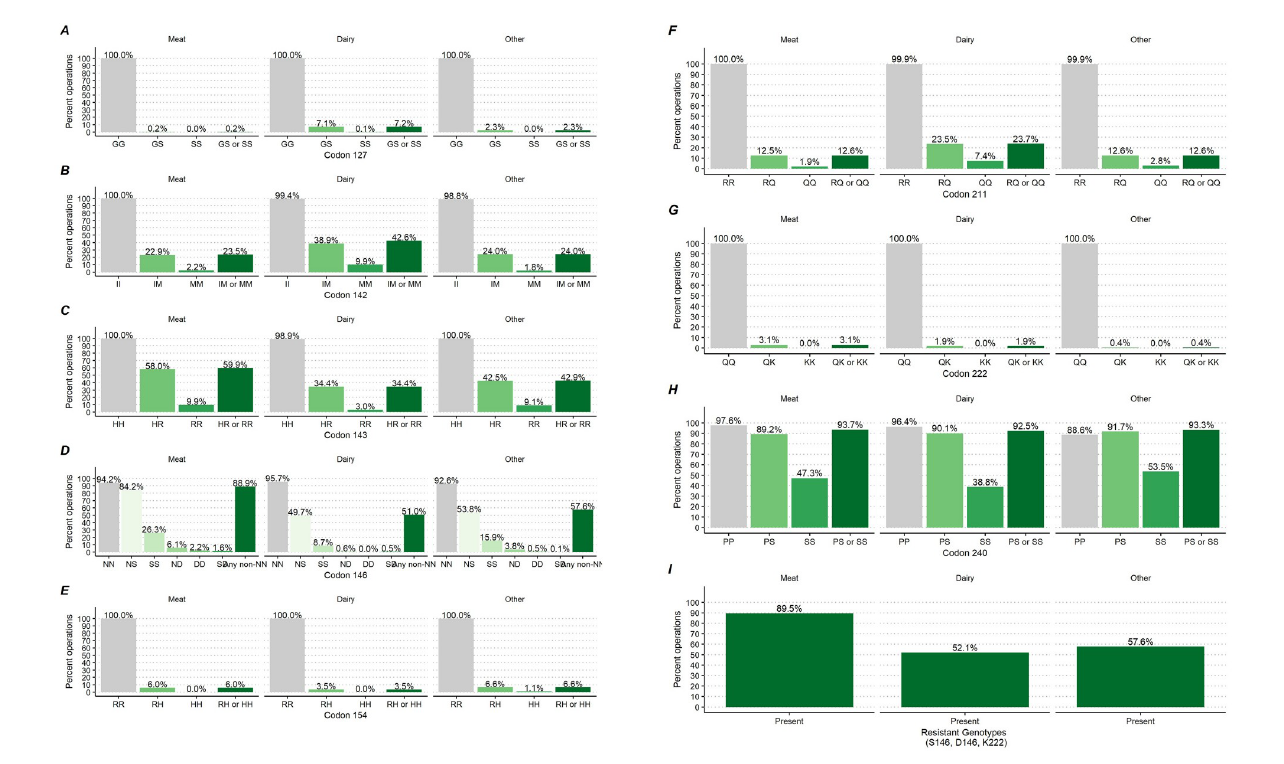
Fig 9. Percentage of goat operations by caprine PRNP polymorphic variants at codons 127, 142, 143, 146, 154, 211, 222 and 240 and by primary production.